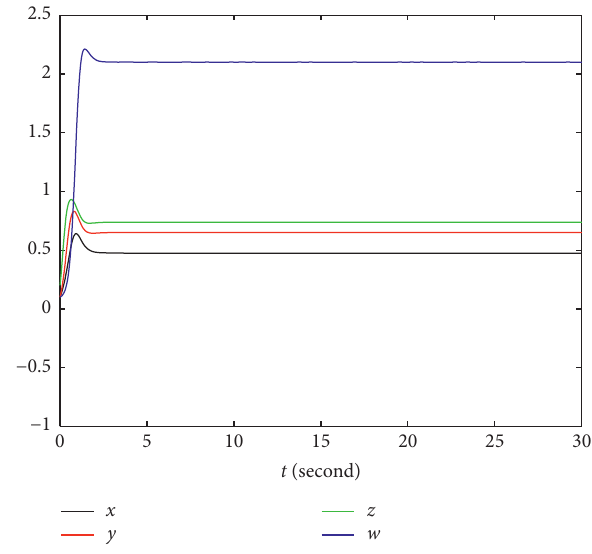
Figure 8: Positive parameters a � 4, b � 6, c � 8, d � 2, e � 3, and f � 2 corresponding to internal solution in equation (16) as (0.475, 0.65, 0.7375, 2.1).